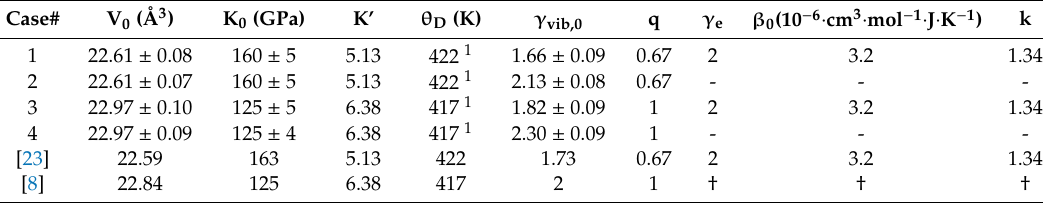
Table 1. Pressure–volume–temperature equation of state (P–V–T EoS) fitting parameters for hcp Fe–5Ni–5Si (cases 1–4) and reported thermoelastic parameters for Fe–5Si [23] and Fe–10Ni–5Si [8]. For